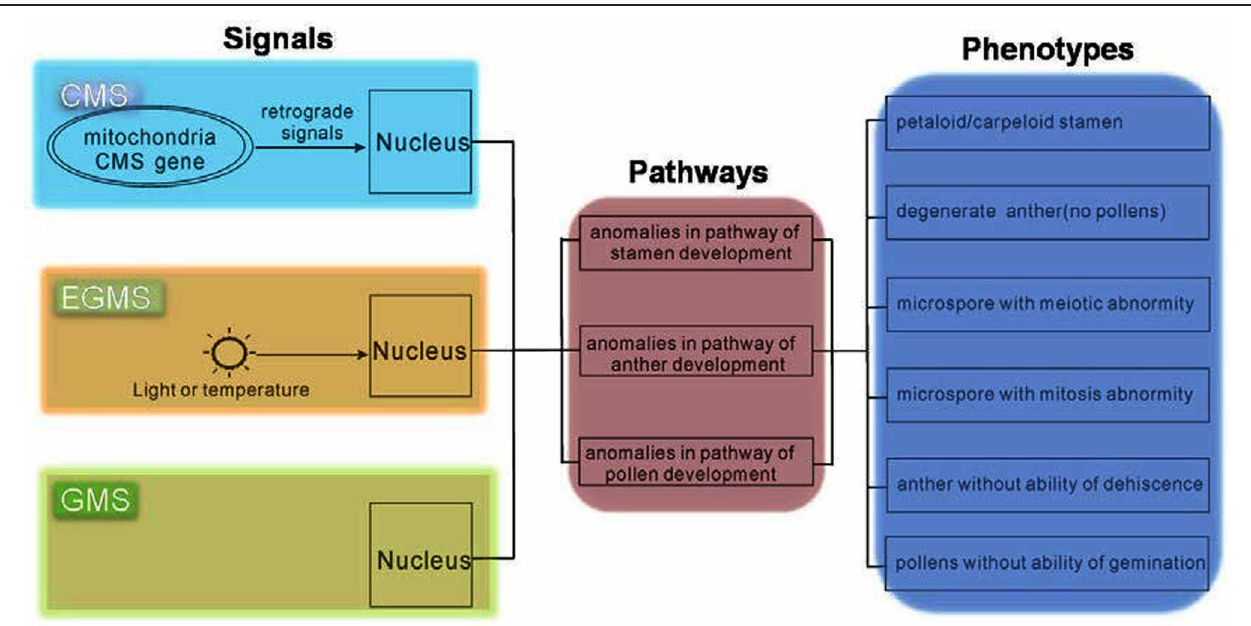
FIGURE 1 | Consensus in regulatory pathways of CMS, EGMS, and GMS. Although the original signals of CMS, EGMS, and GMS are different, the pathways and phenotypes might be the